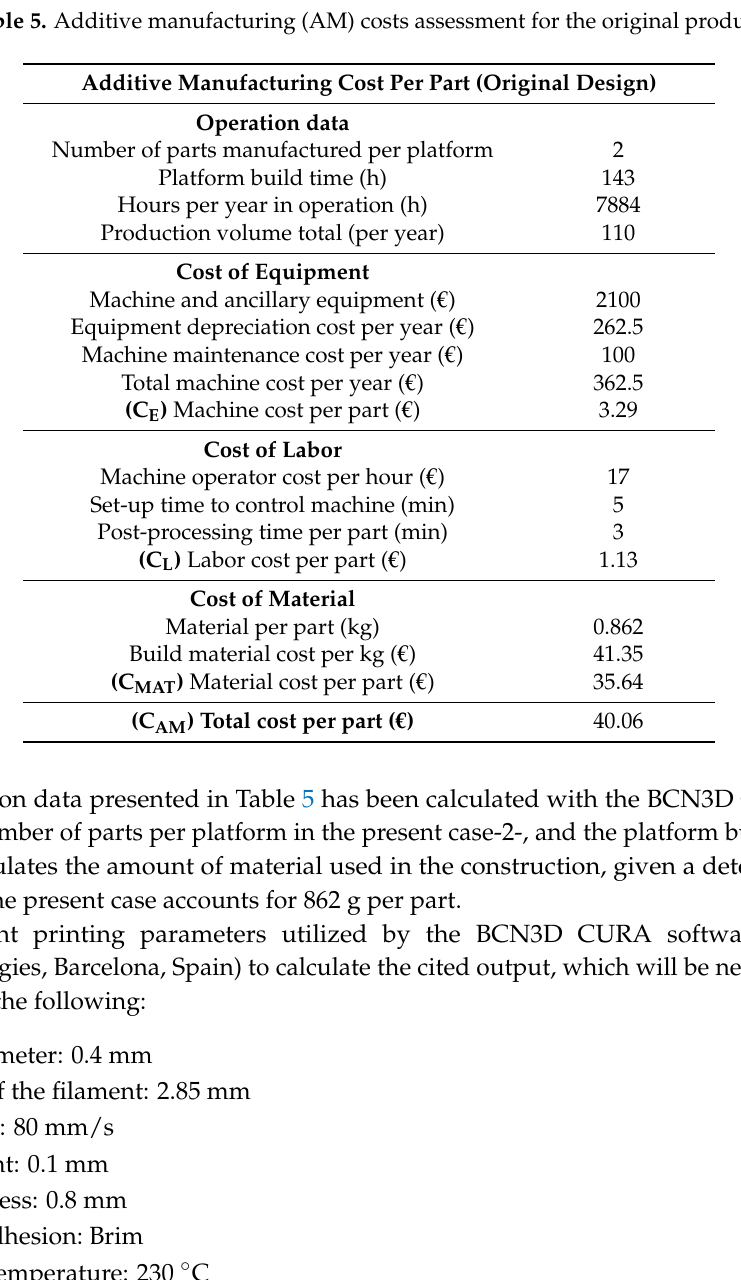
Table 5. Additive manufacturing (AM) costs assessment for the original